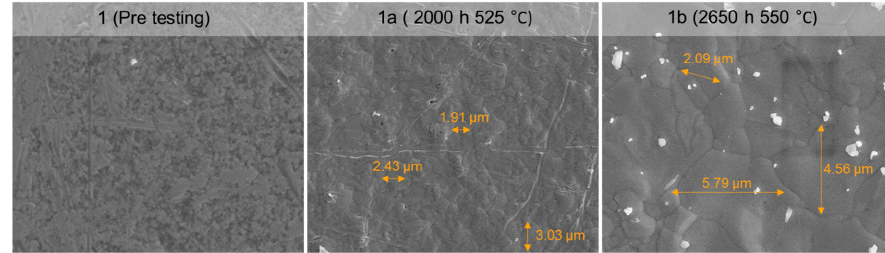
Figure 13. SEM pictures of the surface of membrane 1 pre-testing, after 2000 h and after 2650 h.